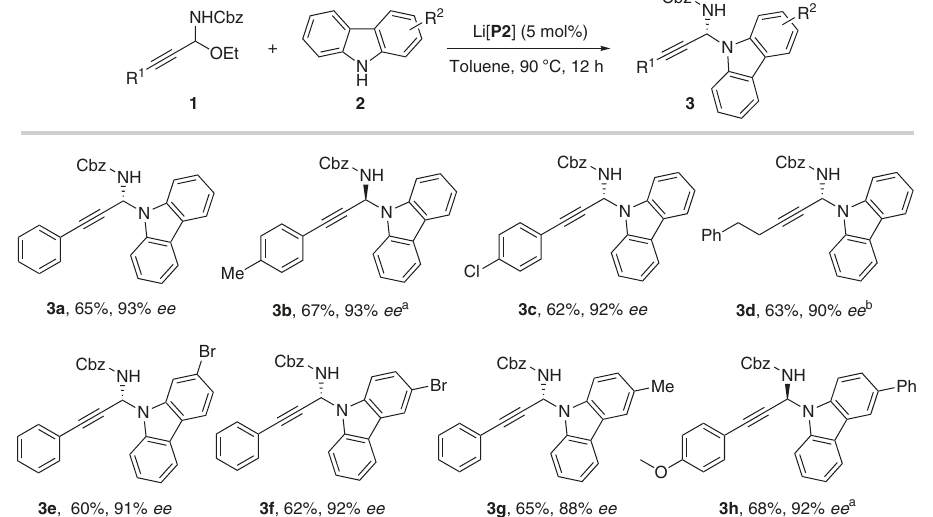
Fig. 5 Scope of N-propargylation of carbazoles. Reaction conditions: 1 (0.08 mmol), 2 (0.05 mmol), ( R )-Li[ P2 ] (5 mol%), toluene (1 mL). a Run with ( S )- Li[ P2 ]. b Run at 100